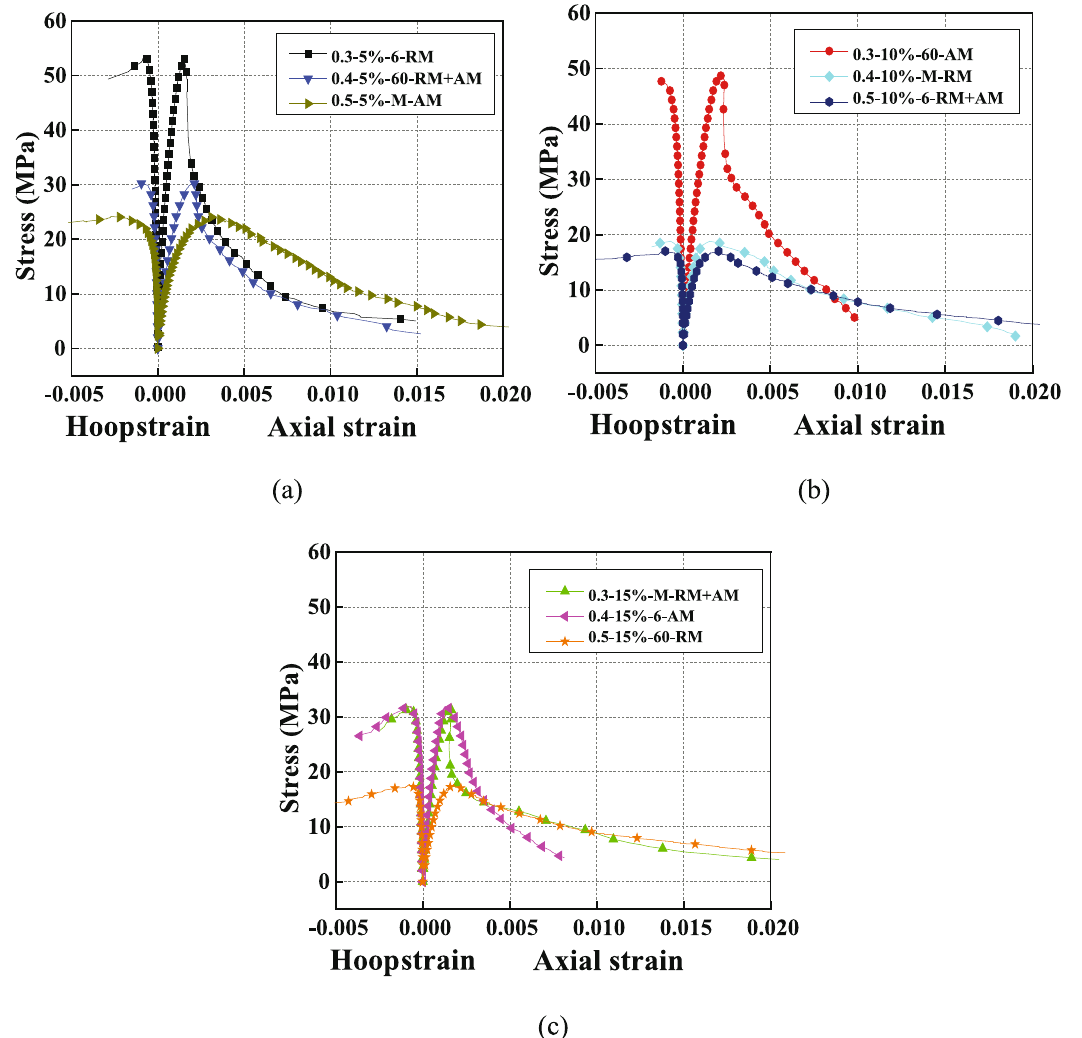
Figure 14: Stress – strain curve of RRAC with di ff erent rubber contents of: ( a ) 5%, ( b ) 10%, and ( c )